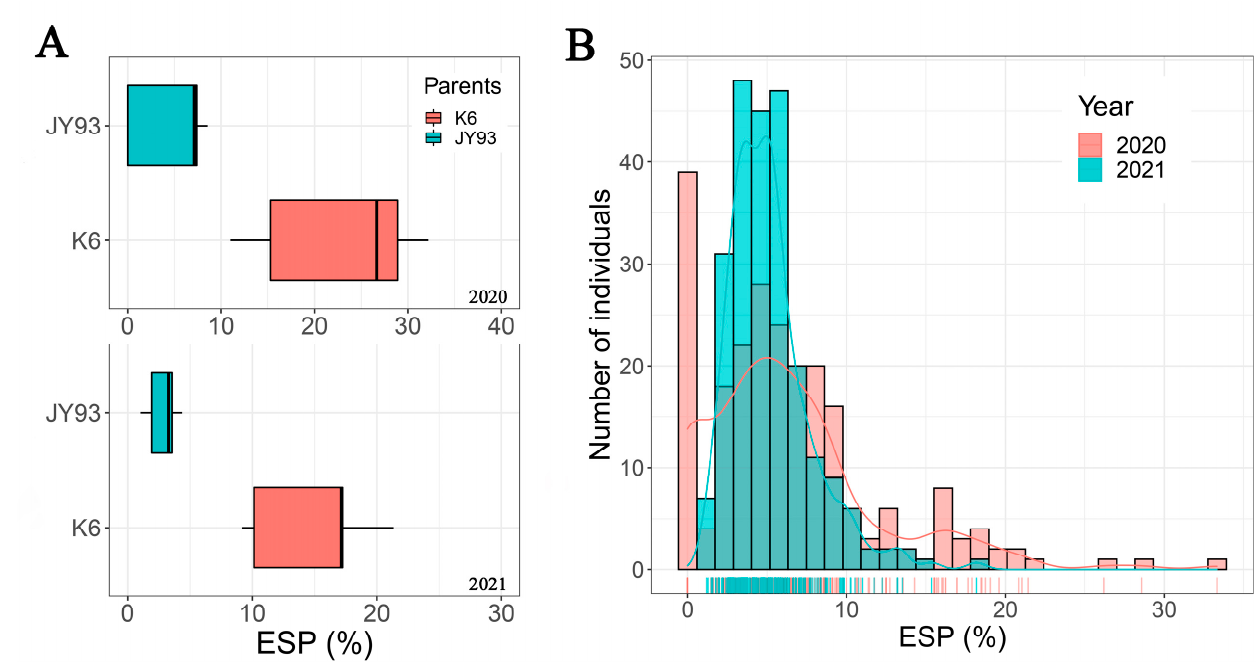
Figure 1. ( A ) Distribution of ESP between two parents: phenotypic data in 2020 (top graph) and 2021 (bottom graph). ( B ) Frequency distribution of ESP and statistical analysis of offspring populations: X-axis is ESP (%) and vertical line on the axis is distribution of population data, and Y-axis is count of population distribution.